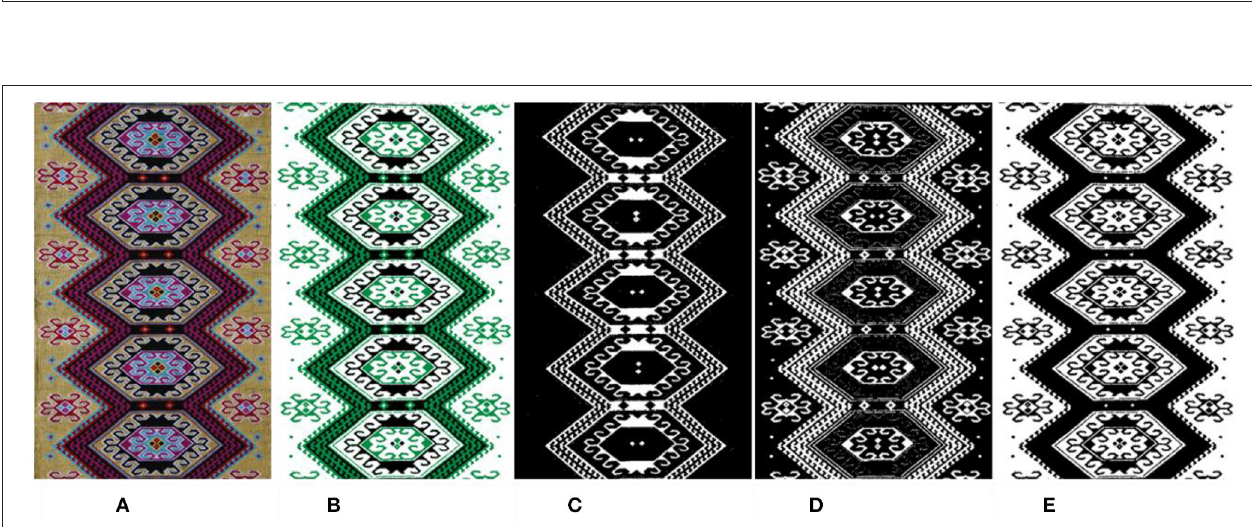
FIGURE 5 | Binarized images of the clustering categories. (A) Image: Original. (B) Cluster ( k = 3). (C) Binary Image (Label = 0). (D) Binary Image (Label = 1). (E) Binary Image (Label = 2).